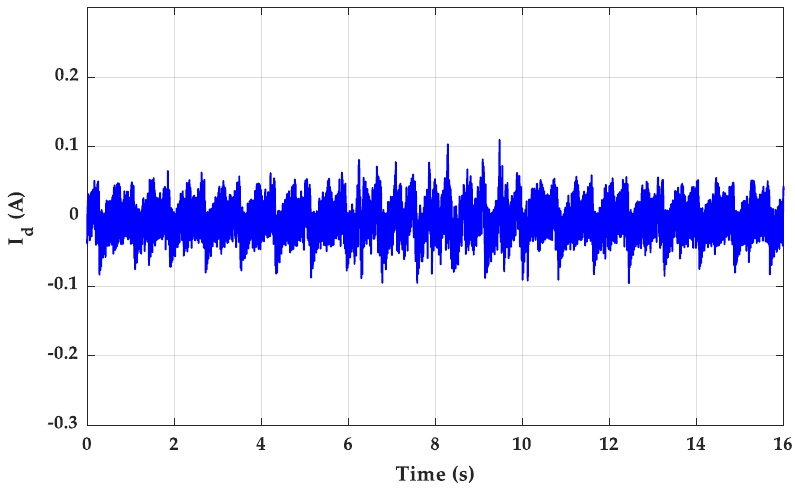
Figure 10. The VSI output d -axis current component (Experiment 1).